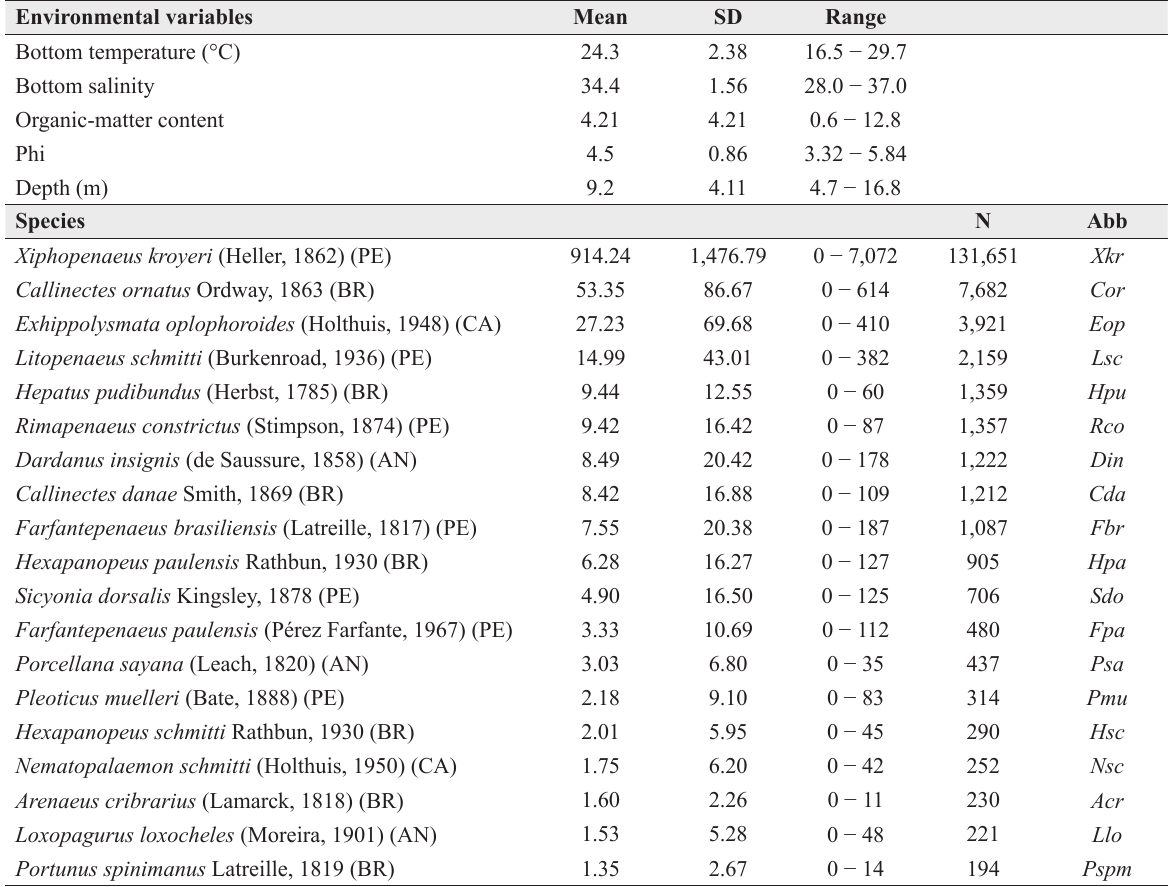
Data for environmental variables and the numbers of individuals of species with a frequency of occurrence greater than 5%, during the study period (January 1998 through December 1999) in the Ubatuba region. Environmental variables Bottom temperature (°C) Bottom salinity Organic-matter